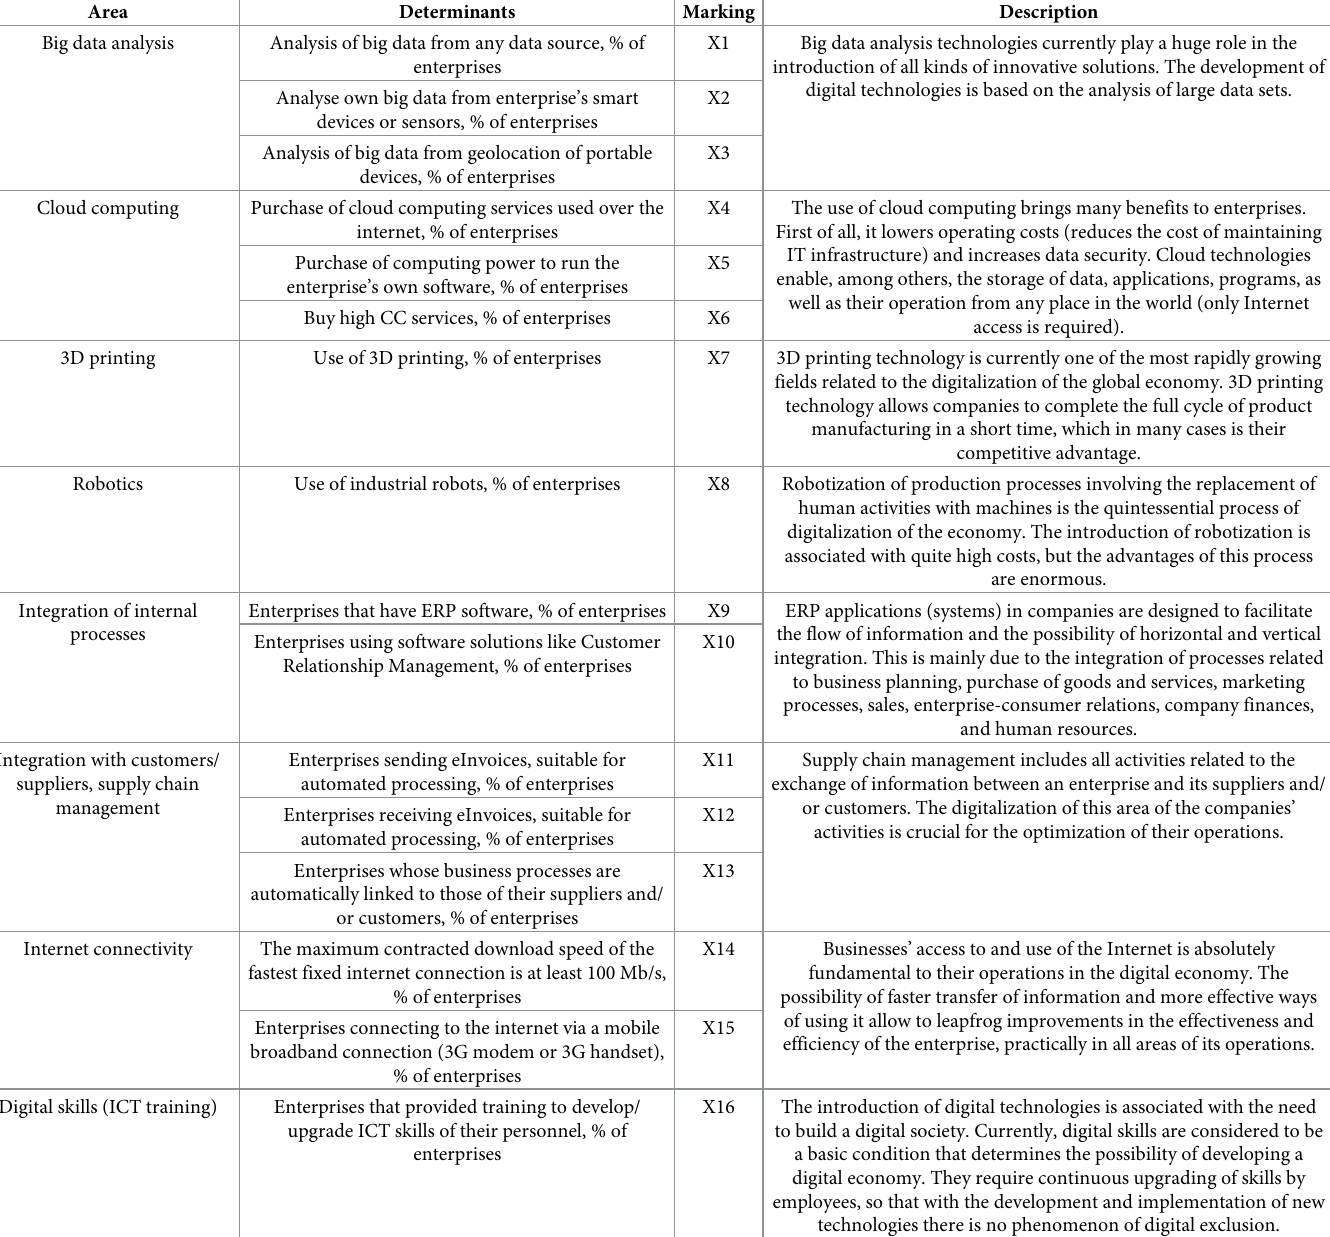
Table 1. Determinants characterizing the processes of digitalization and robotization of enterprises in the EU countries.